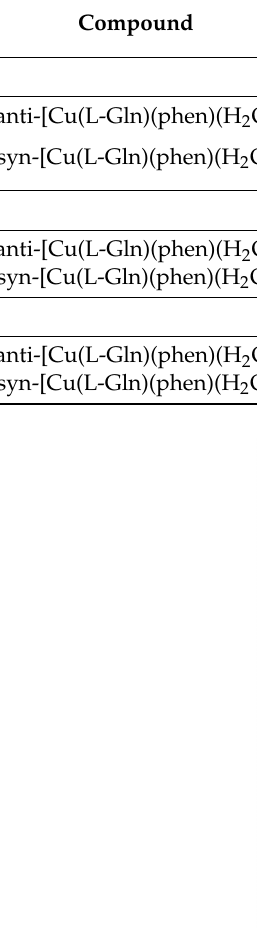
Figure 7. Docked structures of top molecular pose for: ( A ) anti-[Cu(L-Gln)(phen)(H 2 O]-1BNA and ( B ) syn-[Cu(L- Gln)(phen)(H 2 O]-1BNA.